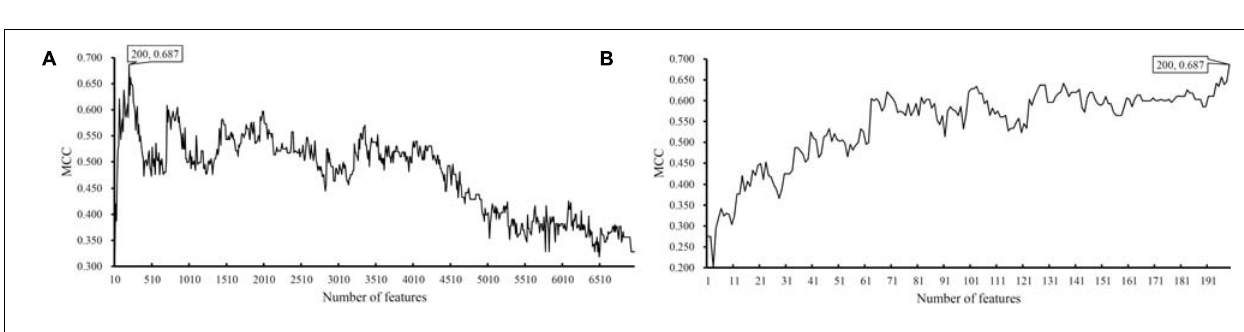
FIGURE 2 | IFS curves with support vector machine (SVM) classifiers on different numbers of eggNOG features. (A) IFS curve with an interval of 10, the highest MCC is 0.844 when top 2090 features are adopted. (B) IFS curve with an interval of one, the highest MCC is still 0.844, however, it can be obtained by only using top 2082 features.